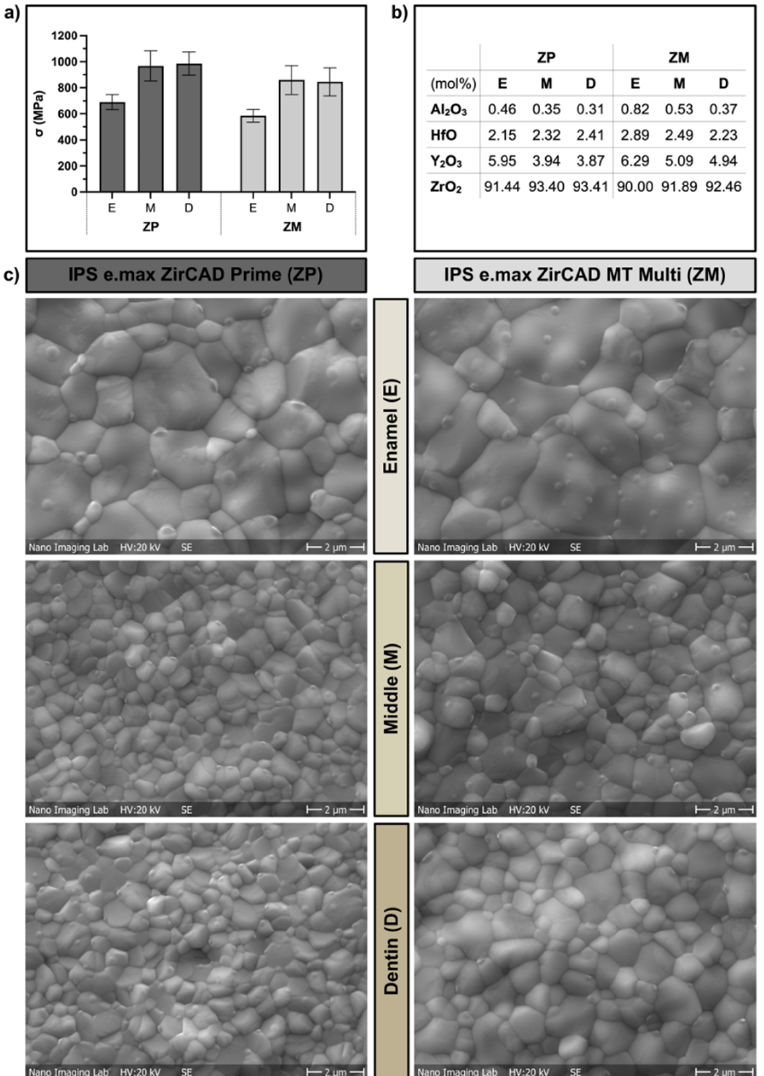
Figure 5. ( a ) Biaxial flexural strength mean values and standard deviations for the different layers (E: enamel, M: middle, D: dentin) of the zirconia disks of materials ZP and PM; ( b ) EDX analysis of